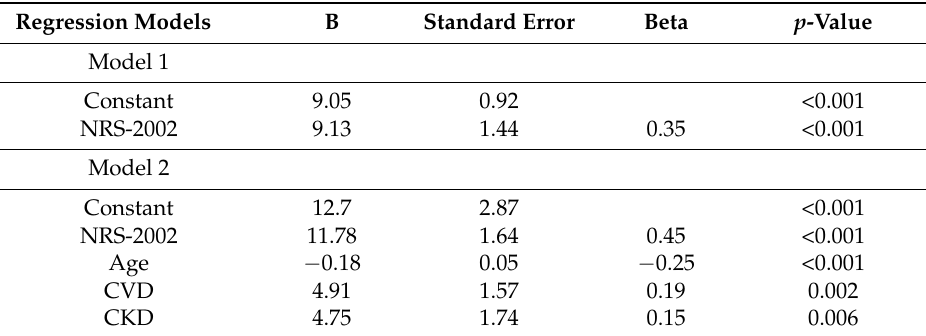
Table 2. Multivariate regression models predicting the duration of hospitalization (the adjusted R 2 of the models were 0.12 and 0.19, respectively; p < 0.001).